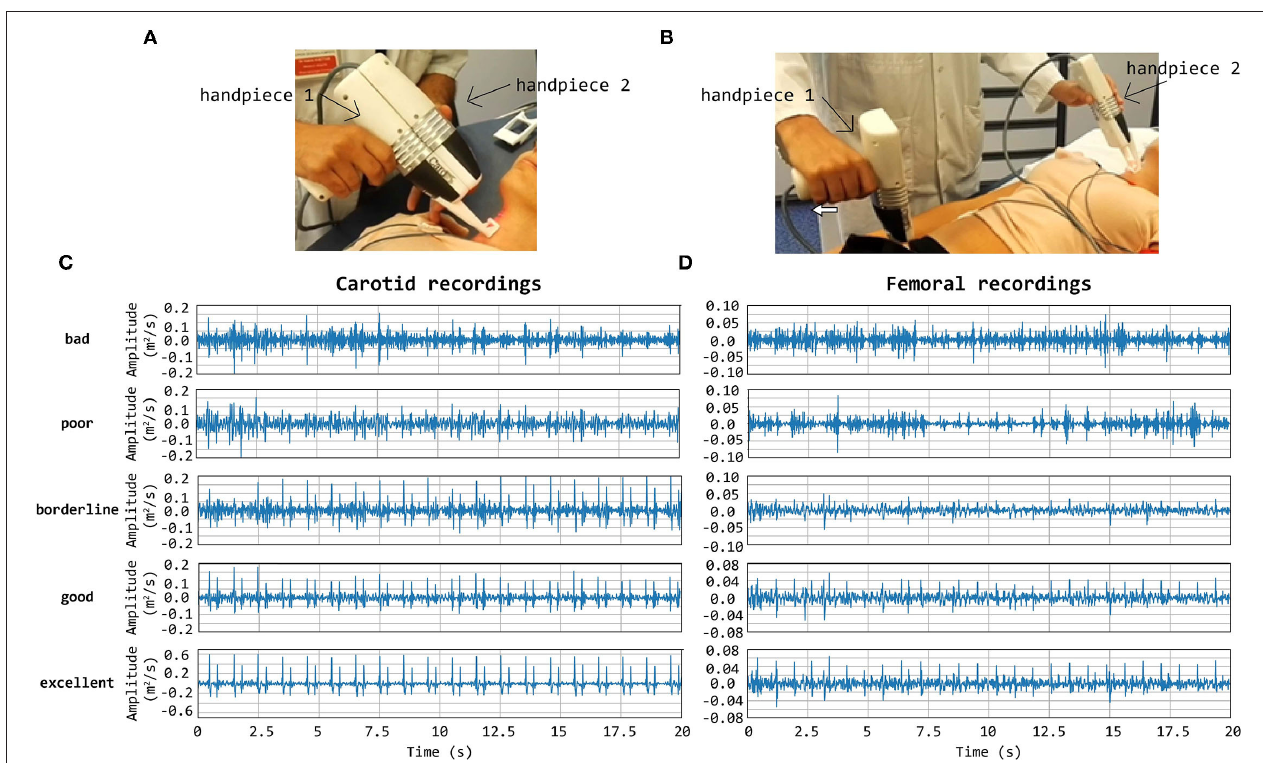
FIGURE 1 | CARDIS device in configuration to measure carotid-femoral (A) and local carotid PWV (B) . (C,D) display representative tracings on the carotid (C) and femoral (D) measuring site receiving a visual grading score of 1–5. Especially in the excellent tracings, the foot-of-the-wave waveforms are clearly visible, with the same for the dicrotic notch waveforms in the local carotid case.